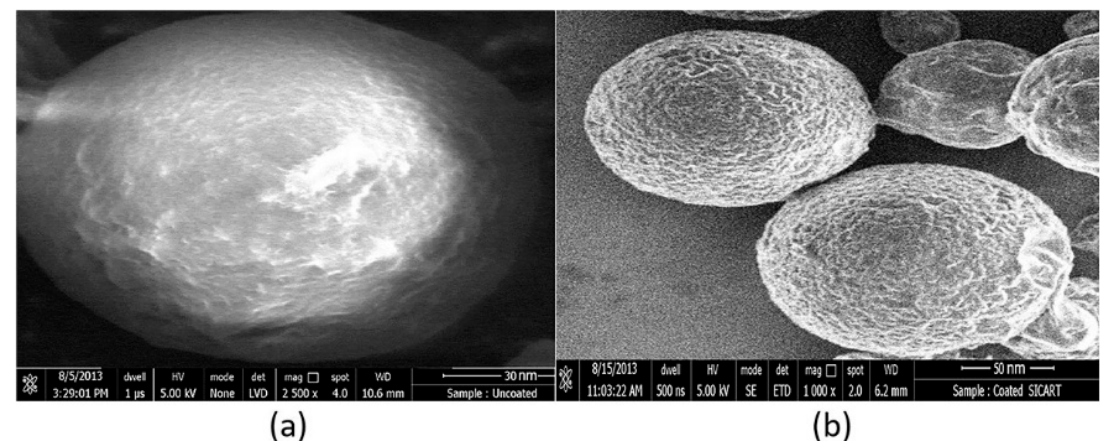
Figure 8. Representative scanning electron pictures of ( a ) uncoated (batch D8), ( b ) coated nanoparticles (batch C1).